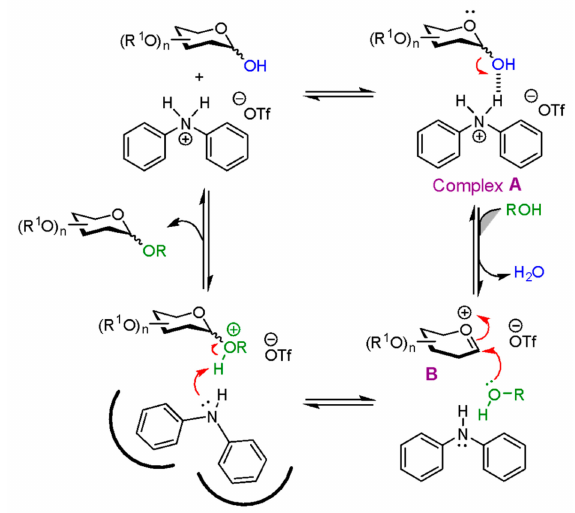
Figure S1: 1H NMR spectra of reaction of 17 and 2d in the presence the of 10 mol% of DPAT ( 3b ) in CD 2 Cl 2 at the ambient temperature for a) 10 min; b) 20 min; c) 30 min: d) 40 min; e) 50 min; f) 60 min; g) 120 min. Figure S2: 1H NMR spectra in CD 2 Cl 2 of a) 17 ; b) 10:1 of mixture of 17 and DPAT (3b ) c) 10:1 of mixture of 17 and [(Mes) 2 NH 2 ][O 3 S(C 6 F 5 )] ( 3a ). Figure S3: 1H NMR spectra of DPAT-catalyzed reaction of 21 and 2d in toluene- d